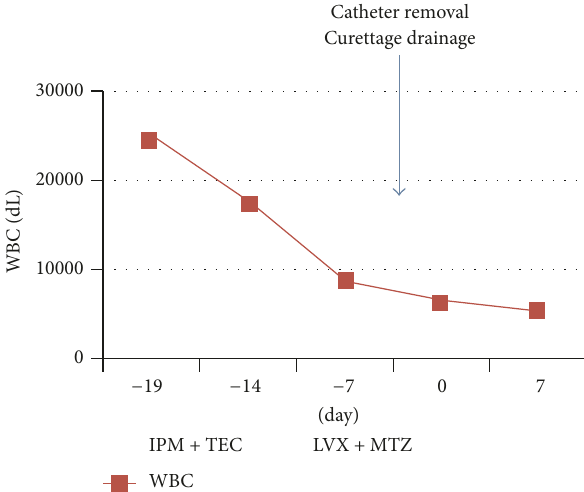
Figure 2: Clinical course. IPM, imipenem; TEC, teicoplanin; LVX, levofloxacin; MTZ, metronidazole.